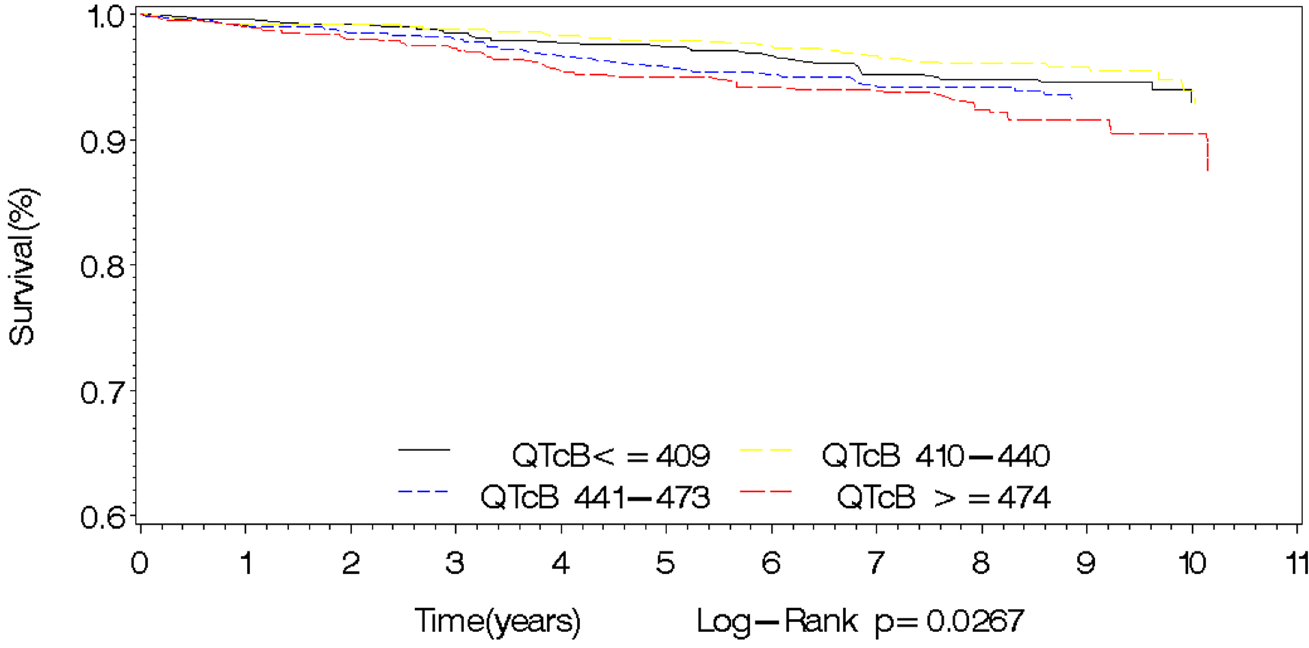
Fig 2. Kaplan Meier survival curves for major adverse cardiovascular outcomes by QTcB interval.